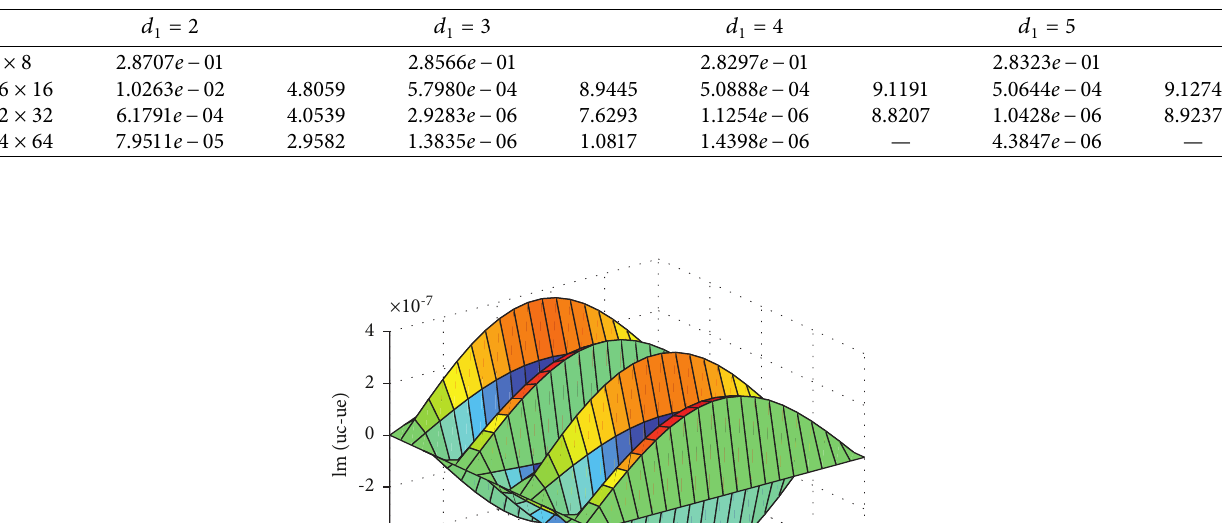
Table 4: Convergence rate of quasi-equidistant nodes with different d